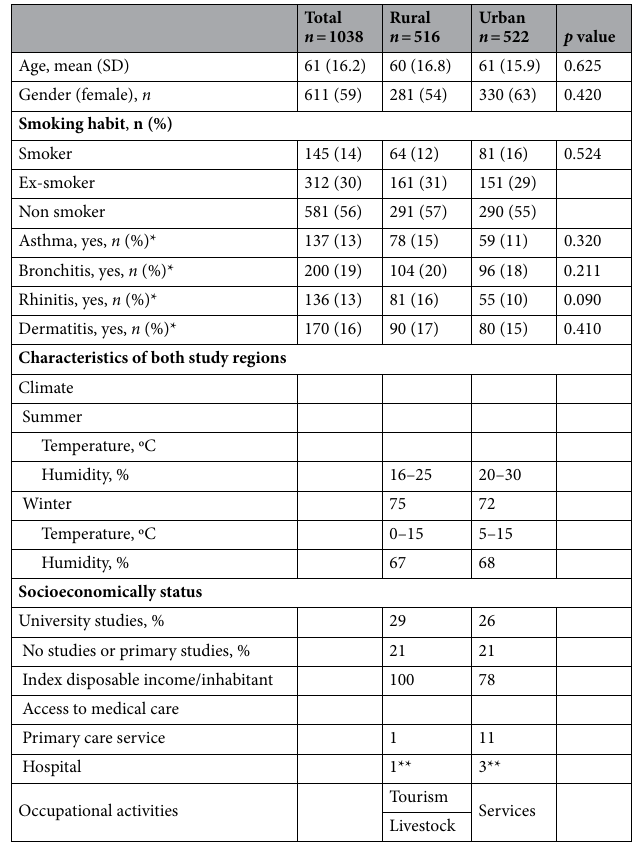
Table 1. Demographic and clinical characteristics of the study populations (Phase I). *Based on positive answers to questions in Q1 (17) **Not exclusive to the